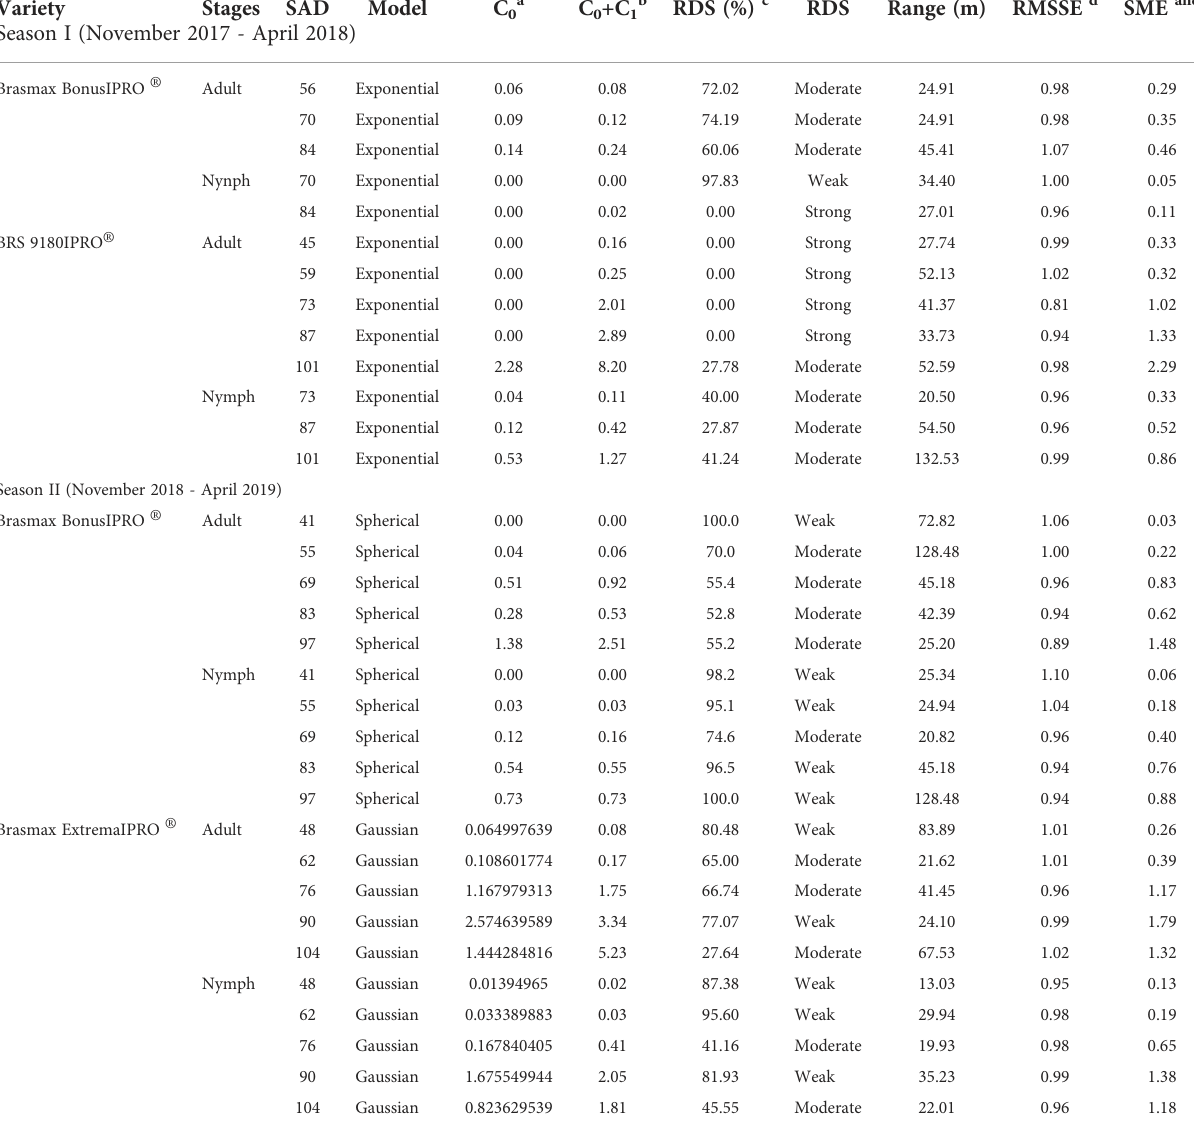
TABLE 2 Models and parameters estimated by semivariogram for Bemisia tabaci adults and nymphs in the cultivars Brasmax BonusIPRO ® , BRS 9180IPRO ® and Brasmax ExtremaIPRO. Variety Stages